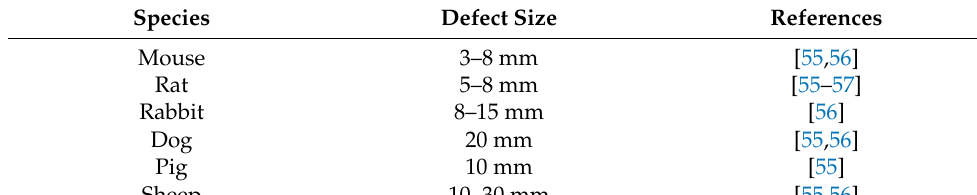
Table 2. Animal models of the calvarial critical-size bone defects.